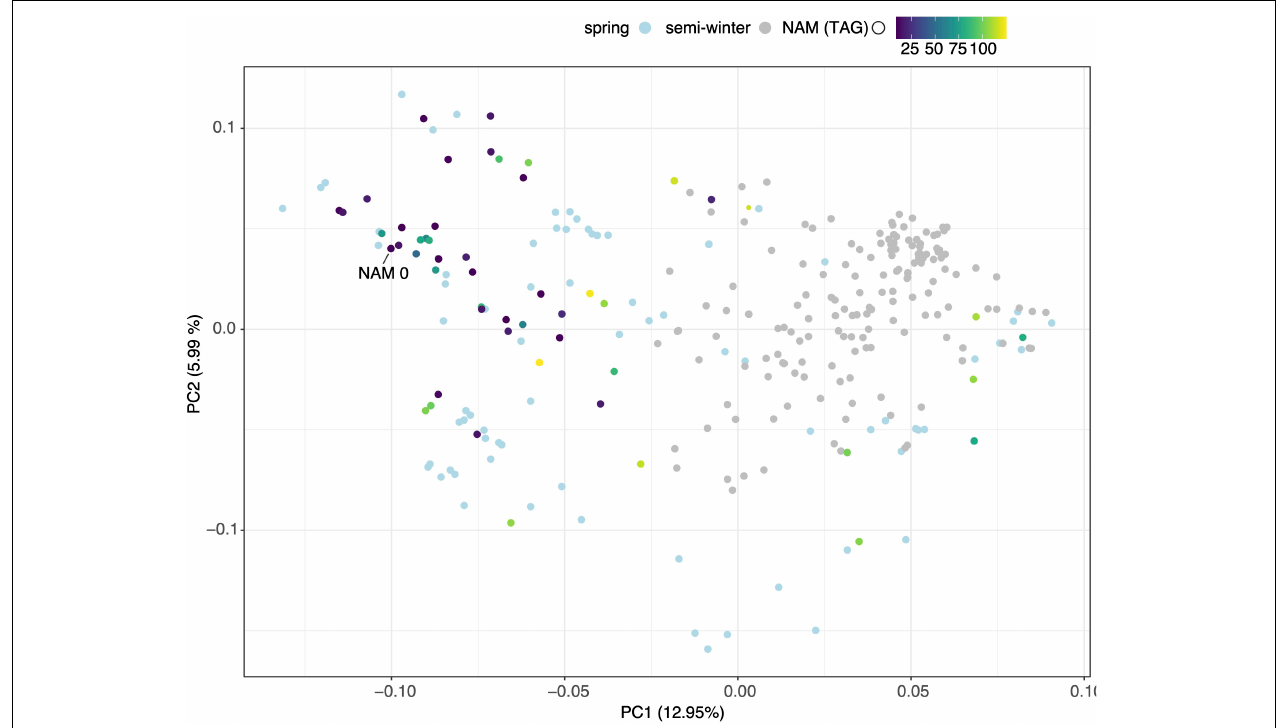
FIGURE 5 | Principal Component Analysis of genotypic diversity of 297 spring (light blue dots) and semi-winter (gray dots) B. napus varieties. Founder lines of SKBnNAM introduced in this study are colored according to their mean total aliphatic glucosinolate (TAG) levels.